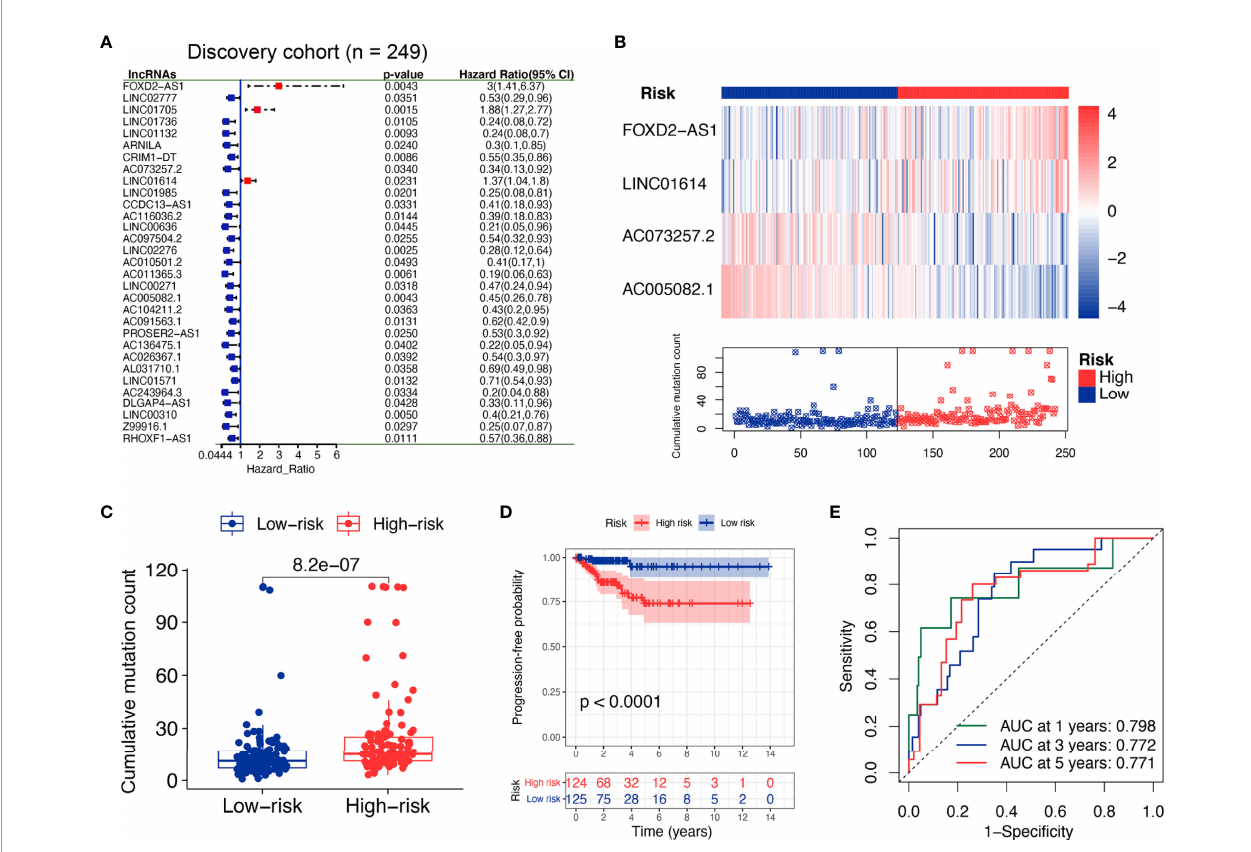
FIGURE 3 | Identi fi cation of the GI-derived lncRNA signature (GILS) for outcome prediction in the discovery set. (A) Univariate Cox analysis of 558 candidate lncRNAs and the resultant 30 lncRNAs, shown in the forest plot with log-rank test p -values, hazard ratios (HR), and con fi dence intervals (B) lncRNA expression patterns and the distribution of somatic mutations. (C) Boxplots of somatic mutations in the GU- and GS-like group. Cumulative mutation counts in the GU-like group are signi fi cantly higher than those in the GS-like group. (D) Kaplan – Meier curves of PFS with low or high risk predicted by GILS in the discovery set. (E) Predictive accuracy of GILS for PFS. Statistical analysis was performed by log-rank test and univariate Cox proportional hazards regression analysis. PFS, progression-free